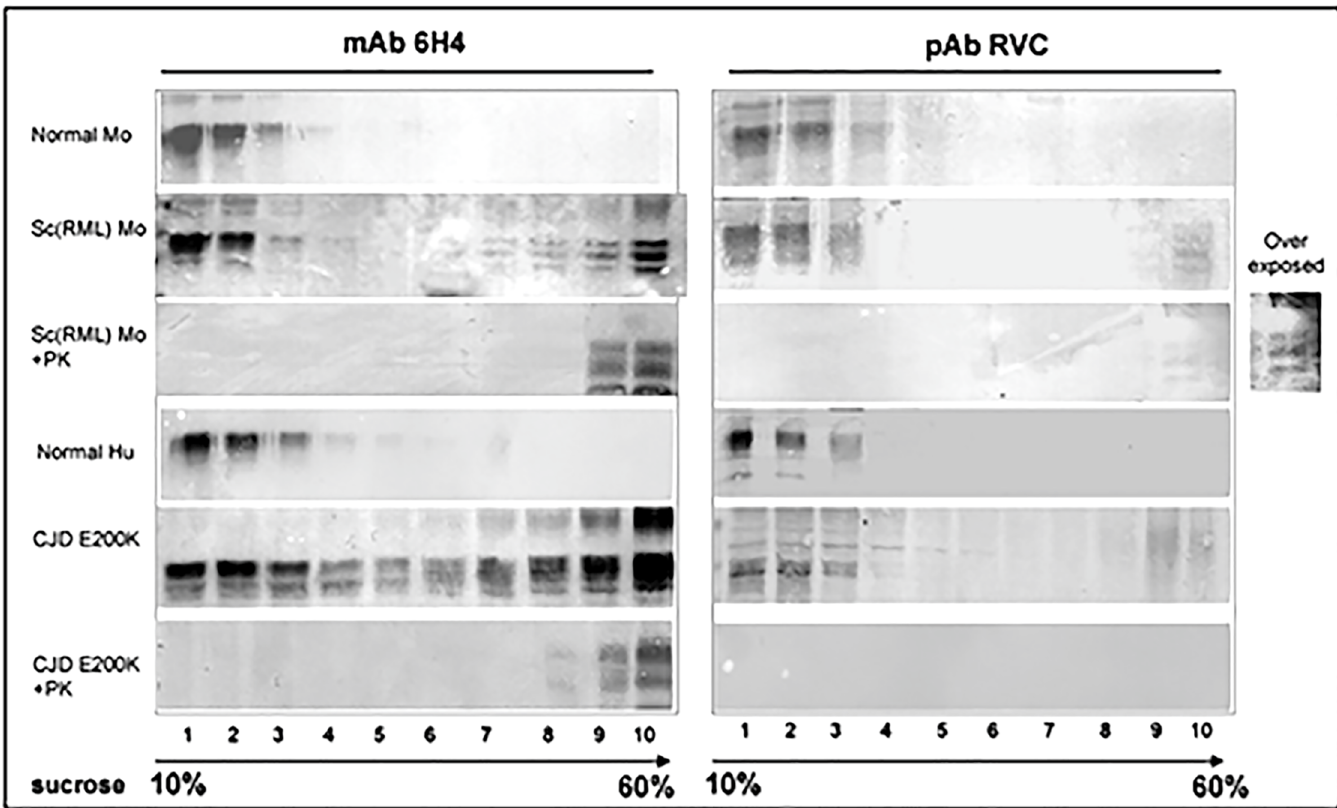
Fig 4. Intermediate PrP forms are oxidized as PrP Sc . Sarkosyl extracted brain samplesfrom normal and prion infected mice and humans were subjected to sucrose gradientcentrifugation. Fractions from these gradientswere digested in the presenceor absenceof proteinase K and immunoblotted with both mAb 6H4 and pAb RVC. As shown in the previous figures of this manuscript, pAbRVC does not